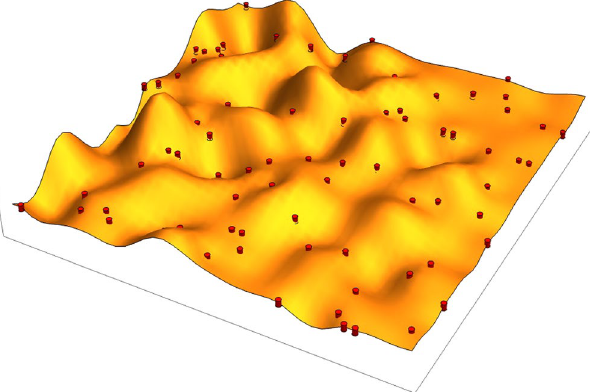
Figure 6. Elastic flexible 2 d sheet on a substrate: pinning centers are indicated as red cylinders.